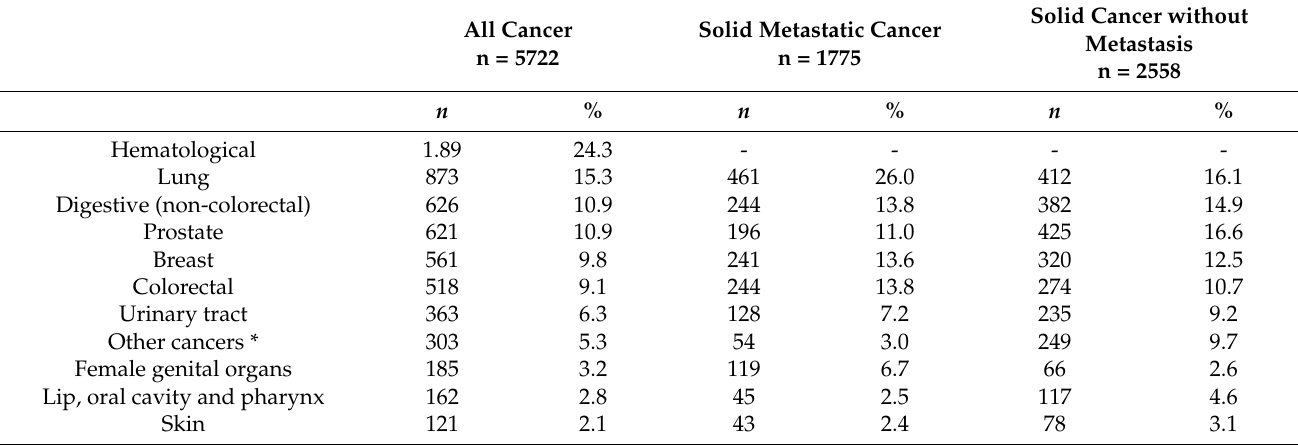
Table 1. Tumour subtypes for cancer patients (with or without metastasis) hospitalized in France for COVID-19 (from